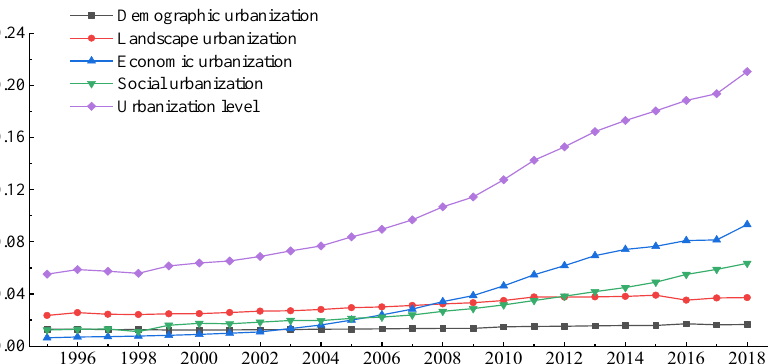
Figure 2. The urbanization level change in the Yellow River Basin (China) from 1995 to 2018.